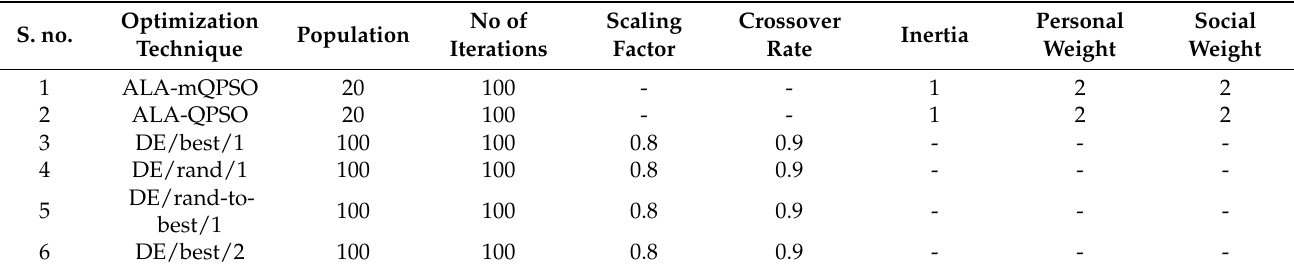
Table 4. Optimization parameters of benchmark techniques.